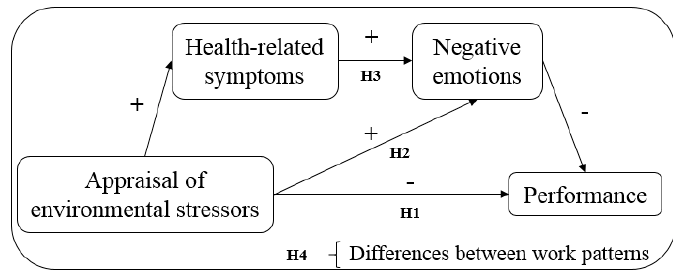
Figure 1. The proposed research model in this study.